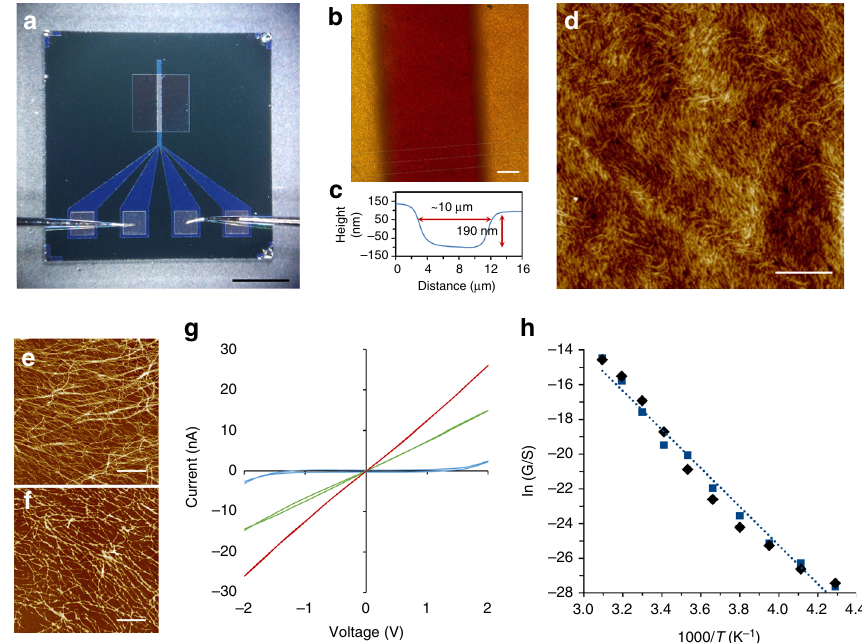
Fig. 3 Electrical characterization of the Au-thioguanosine coordination polymer, 1 . a Patterned platinum MBE showing the contact pads at the bottom and the 10 µ m spaced electrodes above. b , d AFM imaging of the electrode gap region. c A pro fi le of the gap region indicating the size. AFM images before ( e ) and after ( f ) treatment of the xerogel with I 2 . g I-V curves of the 1 before ( blue ) and after doping with tris(4-bromophenyl)ammoniumyl hexachloroantimonate ( red ) and iodine ( green ). h An Arrhenius plot for the zero-bias conductance of the I 2 -doped Au-thioguanosine xerogel. Activation energy ( E a ) = 0.97 ± 0.02 eV obtained from two independent heating ( black )/cooling ( blue ) cycles. Scale bars are 1 mm in image a and 2 µ m in images b , d –